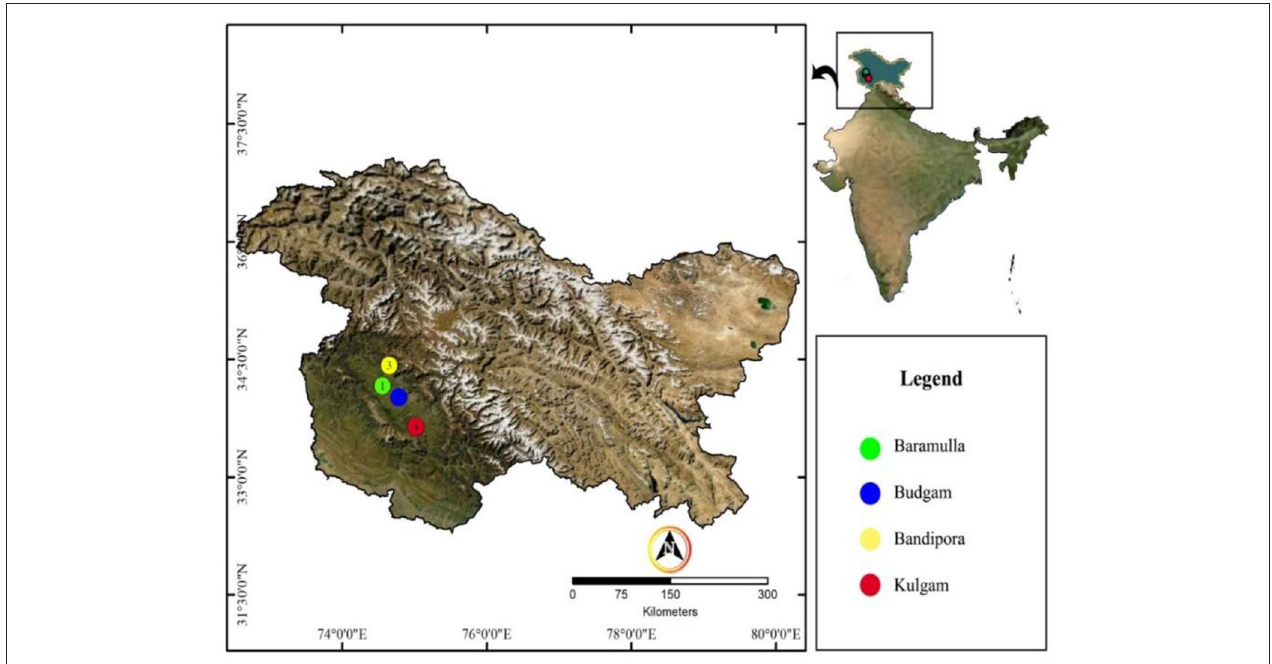
FIGURE 1 | Map showing soil sample collection sites.